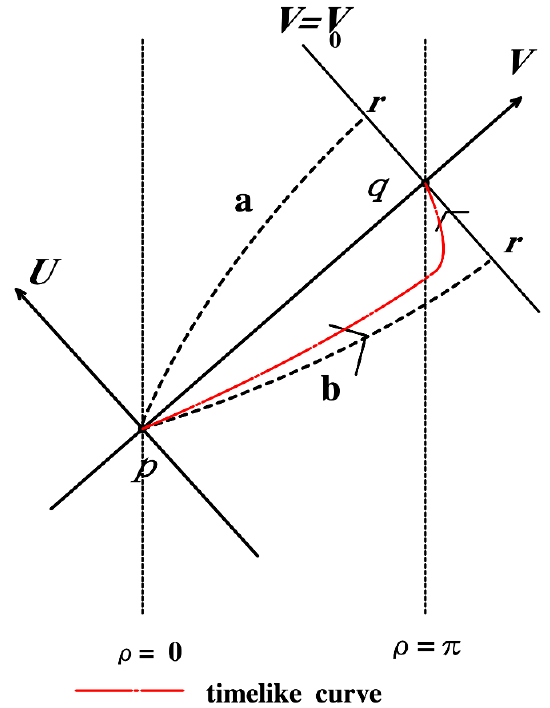
Figure 1 . The dashed curves represent two possible cases of the bulk causal curve (cid:24) that connects two boundary points, the one p at U = V = 0 and the other r on V = V 0 . (i) When r is in the future of q along V = V 0 , the corresponding bulk curve (cid:24) is a delayed curve with respect to the boundary null geodesic (cid:13) with U > 0 at r as depicted by the dashed curve a . (ii) When r is in the past of q along V = V 0 , then (cid:24) becomes a superluminal curve with respect to (cid:13) with U < 0 at r as depicted by the dashed curve b . In the latter case (ii), the broken null curve from p to q through r implies that there is a timelike curve (red broken curve) from p to q